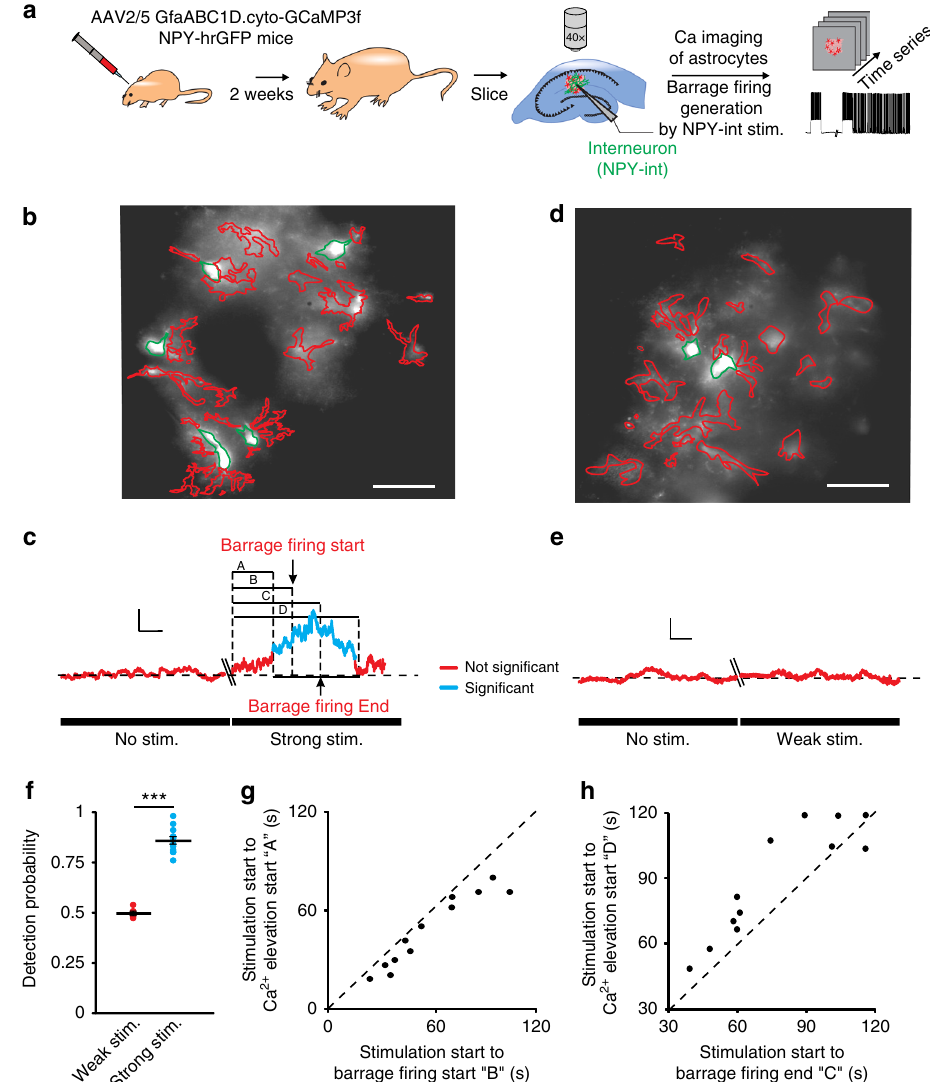
Fig. 3 Calcium transients increase in astrocytes during barrage fi ring induction. a Schematic demonstrating the experimental method. Author T.D. drew the mice and syringe. b Representative image of GFAP-GCaMP3-infected astrocytes illustrating ROI selection. Astrocyte cell bodies outlined in green and their process in red. Scale bar, 40 μ m. c An increase in astrocytic calcium transients (blue) preceded barrage fi ring generation in response to strong stimulation (average of all ROIs shown in b ). Scale bars, 1% Δ F/F , 15 s. Uppercase letters refer to the time from onset of strong stimulation to beginning of detectable of calcium increase (A), barrage fi ring start (B), barrage fi ring end (C), and end of detectable calcium increase (D). In this experiment, strong stimulation was used (i.e., leading to barrage fi ring fi ring). d Representative image of GFAP-GCaMP3-infected astrocytes illustrating ROIs in an experiment with weak stimulation (i.e., not leading to barrage fi ring. Scale bar, 40 μ m. e No increase in astrocytic calcium (red) was observed in the absence of stimulation or with weak stimulation, which did not induce barrage fi ring (average ROIs in d ). Scale bars, 3% Δ F/F , 15 s. f Detection probability for onset of the increase in average calcium transients in astrocytes prior to barrage fi ring onset was high for trials that resulted in barrage fi ring induction ( n = 12 from 8 mice) but not for trials with weak stimuli and therefore no barrage fi ring (i.e., ~50% — or chance — detection probability; n = 6 from 4 mice; *** p < 0.0001). g Astrocytic calcium increases always preceded barrage fi ring onset ( n = 12 from 8 mice). h Termination of barrage fi ring preceded the termination of signi fi cant calcium elevation in astrocytes ( n = 11/12 from 8 mice). Data are represented as mean ±